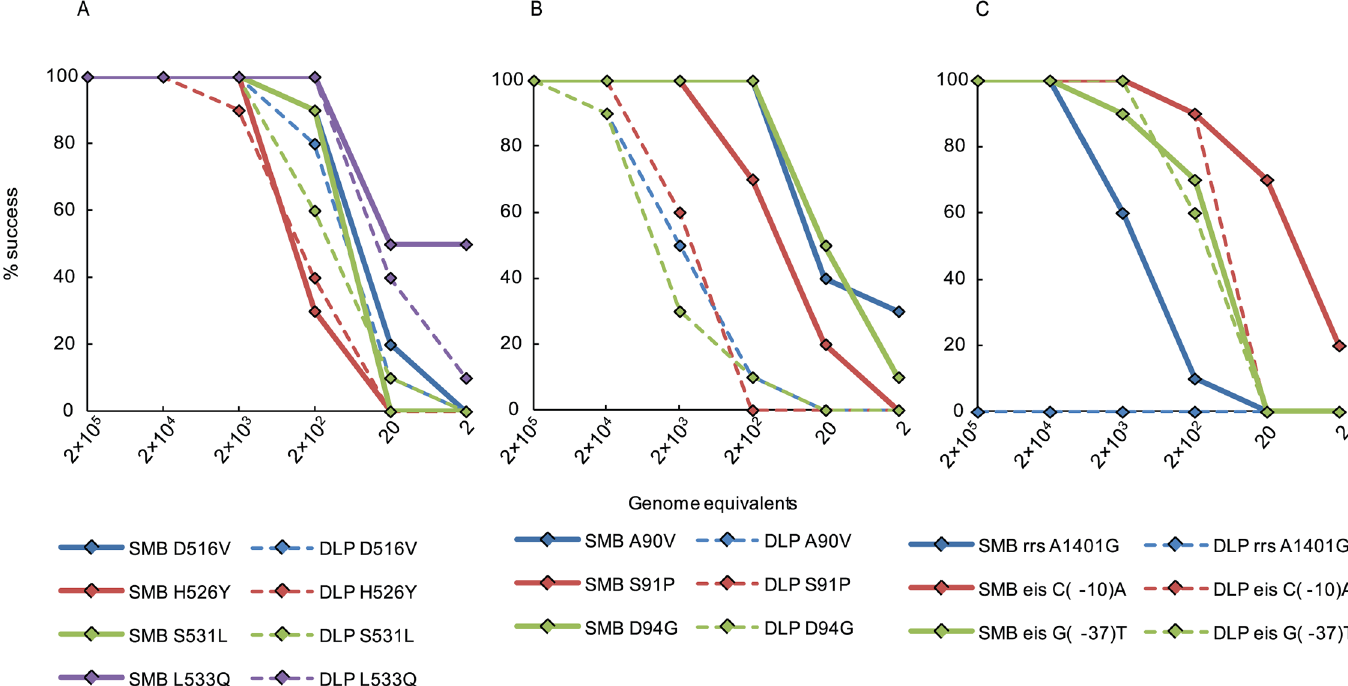
Fig 5. Analytical sensitivity of SMB and DLP probes on mutant DNA from clinical samples. Success rates for the detection of selected mutants by the SMB and the DLP assays are shown. Panel (A) rpoB mutants; panel (B) gyrA mutants and panel (C) rrs / eis mutants. Solid lines show SMB assay performance and dotted lines show DLP assay performance.